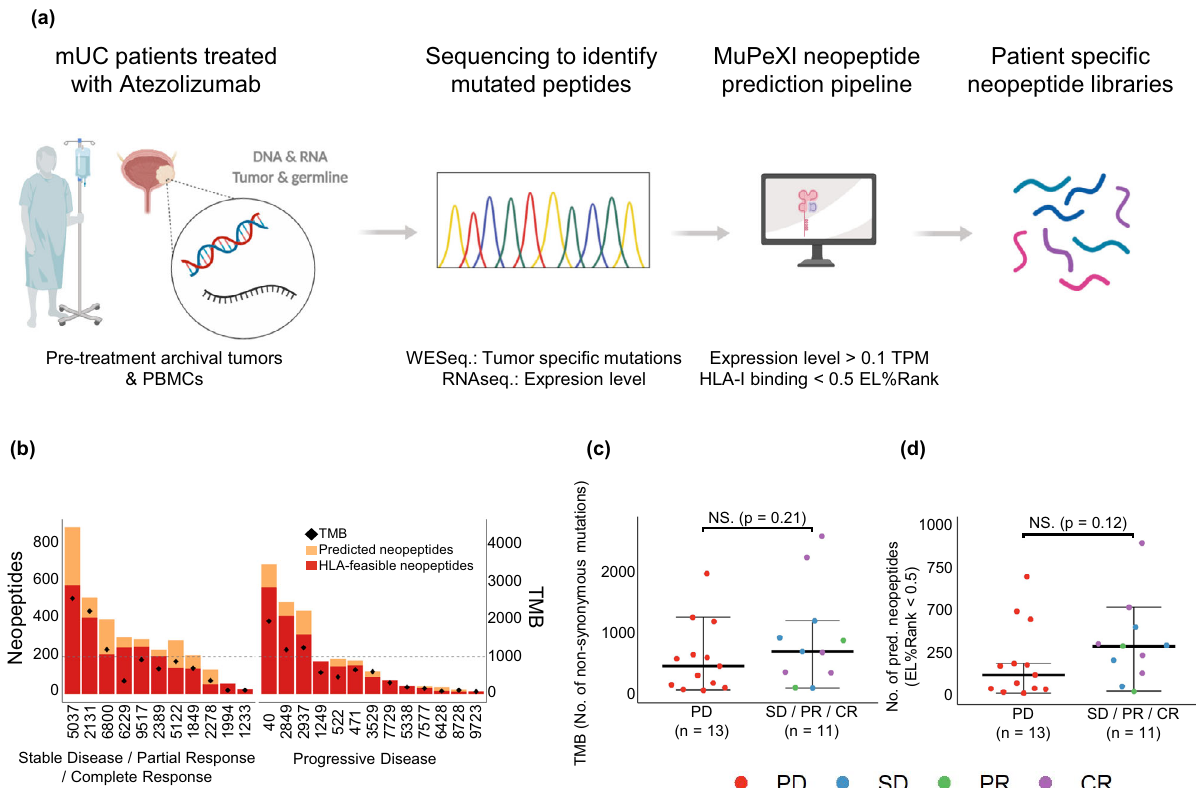
Fig. 1 Prediction of patient-speci fi c neopeptides. a Overview of work fl ow for identi fi cation and prediction of mutation-derived neopeptides in mUC patients. Created with BioRender.com. b Number of predicted and HLA-feasible neopeptides with EL%Rank <0.5, and TMB (diamond) in the patient cohort. Patients grouped according to best RECIST 1.1 criteria, PD ( n = 13 patients; median = 123, range = 16 – 700 neopeptides with EL%Rank <0.5 predicted) and SD/PR/CR patients ( n = 11 patients; median = 292, range = 26 – 898 neopeptides with EL%Rank <0.5 predicted). Dotted line represents minimum 200 neopeptides included in panel for each patient. c , d TMB and number of prediced neopeptides with EL%Rank <0.5 for patients with PD compared to SD/ PR/CR patients. For ( c , d ) groups were compared using non-parametric two-sided Mann – Whitney test and data is presented as median values ± largest/ smallest value within upper/lower quartile ± 1.5 IQR. NS. Not Signi fi cant. Source data are provided as a Source Data fi